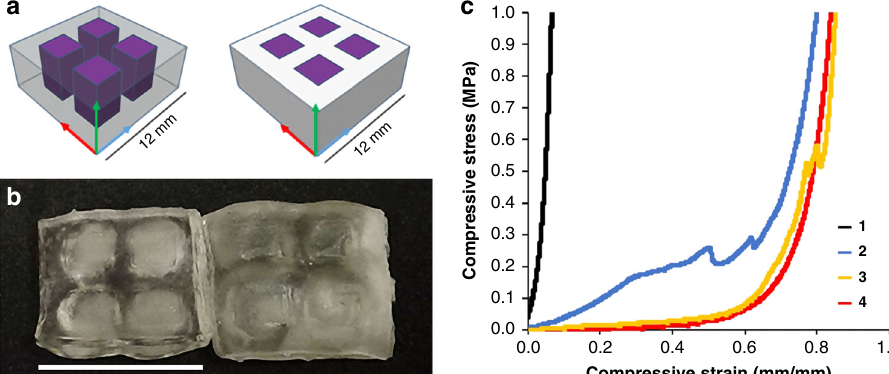
Fig. 3 Design, print, and representative stress-strain plot from compression testing of multimaterial HEA-1 printed specimens. a CAD models of 4-pillar multimaterial objects and representative printed specimens. Purple corresponds to pillars printed with UV light and white/transparent outer region corresponds to components printed with visible light. Arrows denote axis of printing: x -axis (blue), y -axis (red), z -axis (green). b Printed specimens: (left) no thermal post-cure; (right) 3-h thermal post-cure at 60 °C; each using 1-min layer cure times. As-printed outer object dimensions: 12 × 12 × 5 mm 3 . Pillar dimensions: 3 × 3 × 5 mm 3 with 2-mm spacing. Scale bar corresponds to 12 mm. c Representative compressive stress-strain plots of HEA-1 specimens. All boxes printed with 1-min layer cure times and post-cured for 3 h at 60 °C. Black (1) = homogeneous sample cured with UV light. Blue (2) = pillar box sample compressed along the z -axis. Yellow (3) = pillar box sample compressed along the x -axis. Red (4) = homogeneous sample cured with visible light